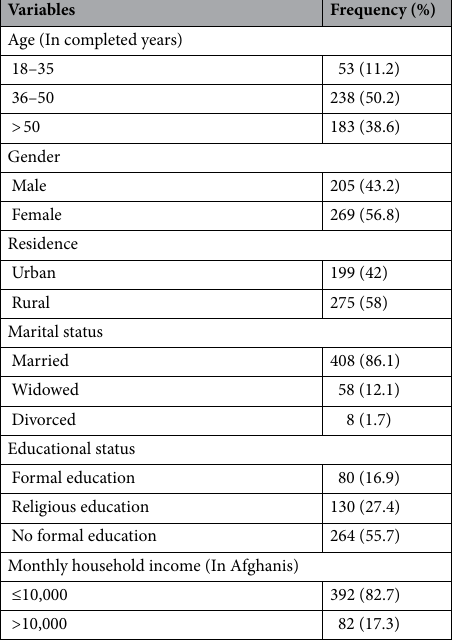
Table 1. Socio-demographic characteristics of the study participants (N =